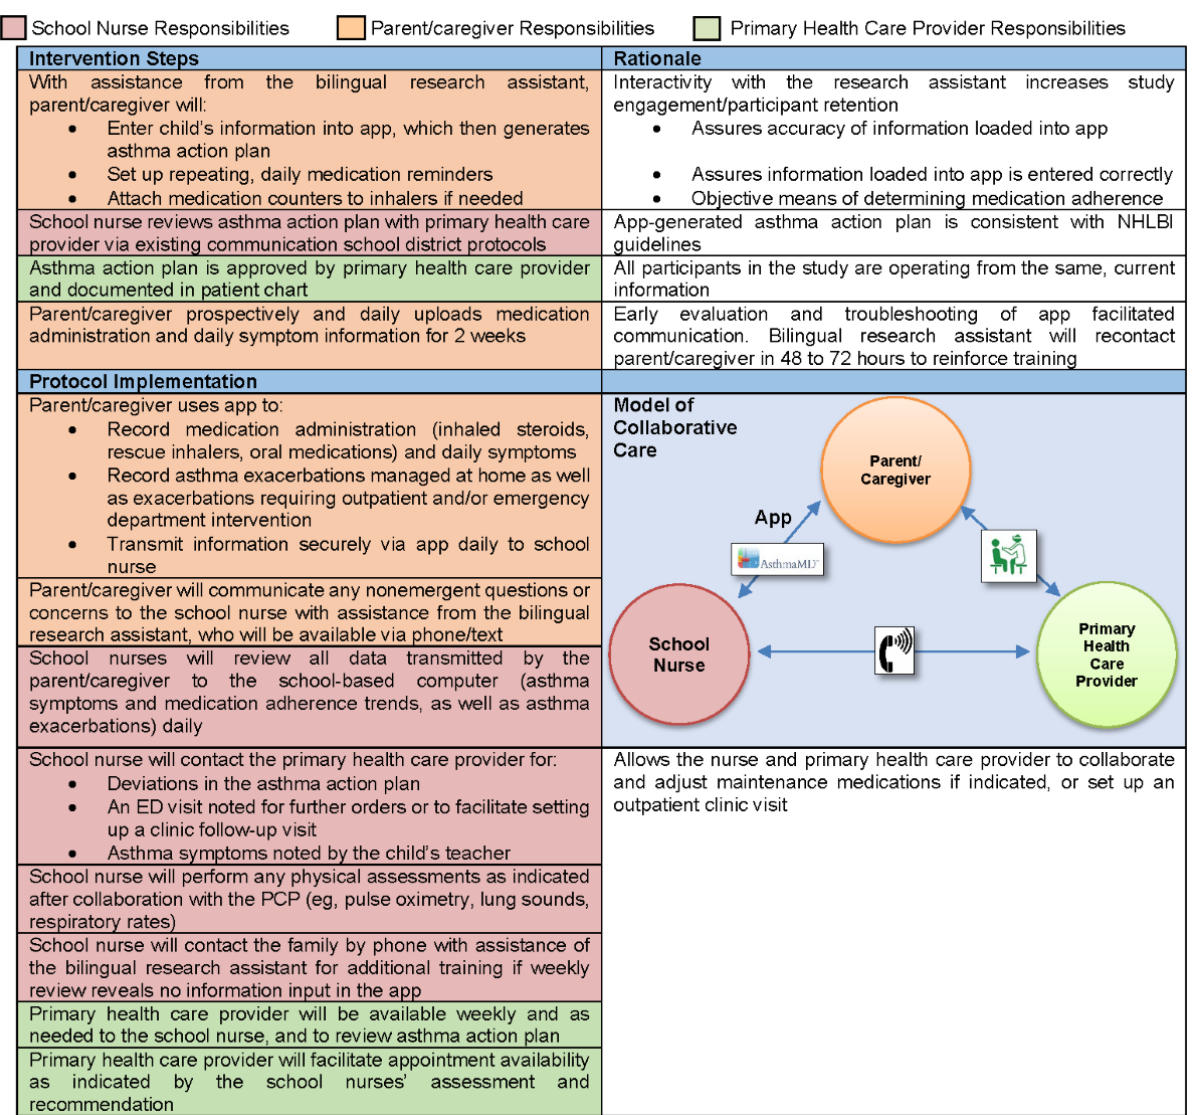
Figure 2. Preliminary protocol. ED: emergency department; NHLBI: National Heart, Lung, and Blood Institute; PCP: primary care